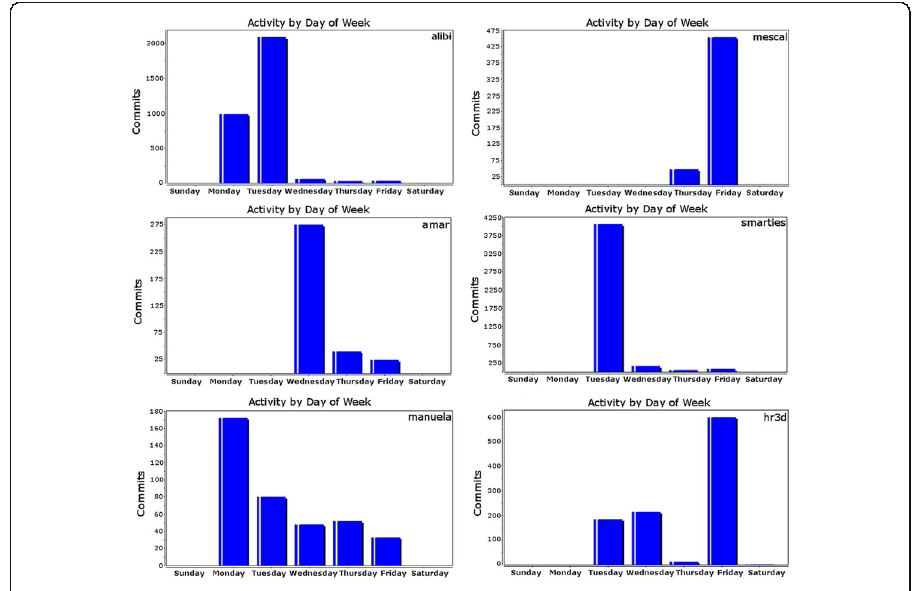
Table 2 Quality assessment of the projects ’ outcome on six dimensions by a human expert Dimensions alibi amar h3rd mescal manuela smartIES Creativity